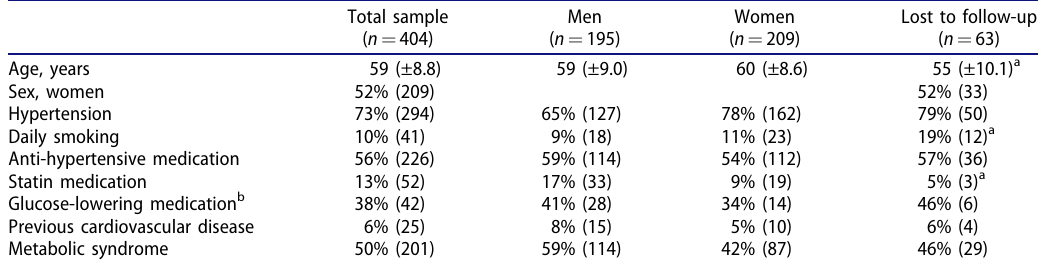
Table 1. Baseline characteristics of the study population and patients lost to follow-up.